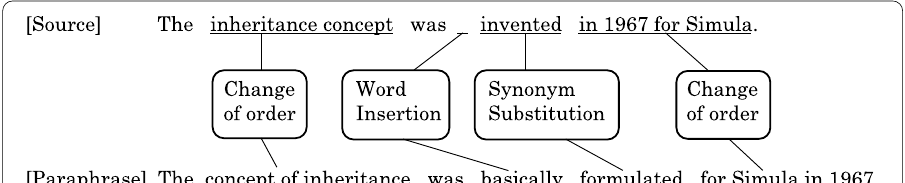
Fig. 3 Examples of Paraphrase Types in a pair of source and paraphrased sentences